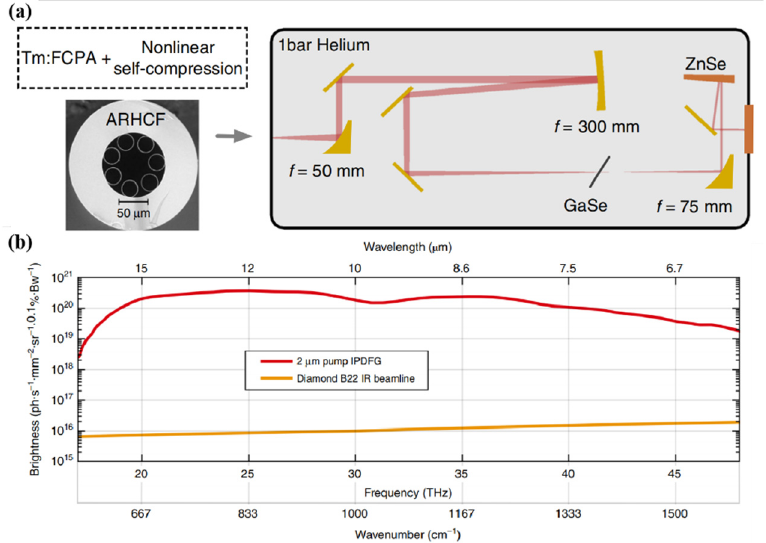
Figure 16. ( a ) Schematic experimental setup for IPDFG. ( b ) Brightness comparison of IPDPG and synchrotron radiation. High-power MIR spectra generated by IPDFG pumped at 2 μ m wavelength (this work, red). The brightness of the high-power table-top MIR source in this work exceeds that of large-scale facility synchrotrons, e.g., the Diamond B22 IR beamline [66], by 4 orders of magnitude in the 7.5–15 μ m wavelength range. Reprinted with permission from [60].